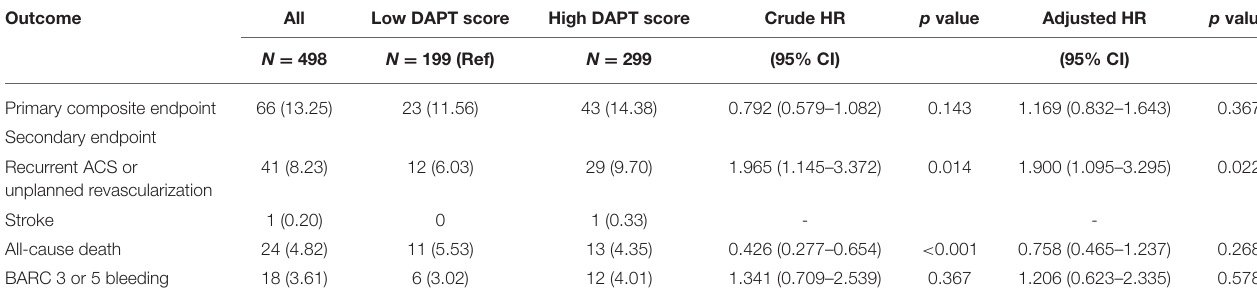
TABLE 3 | Clinical outcomes at 12-months follow-up.